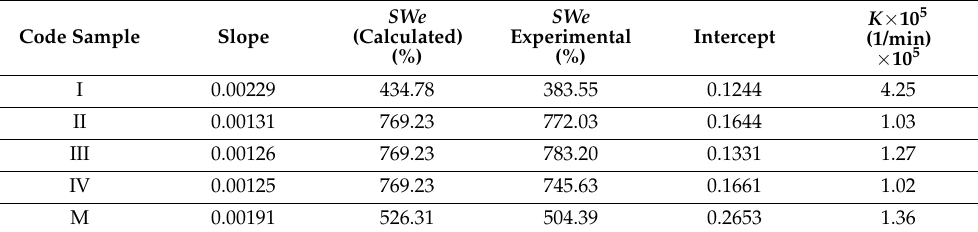
Table 2. The values of the rate constant ( K ) and the swelling degree ( SWe ) calculated based on Schott’s equation and experimentally